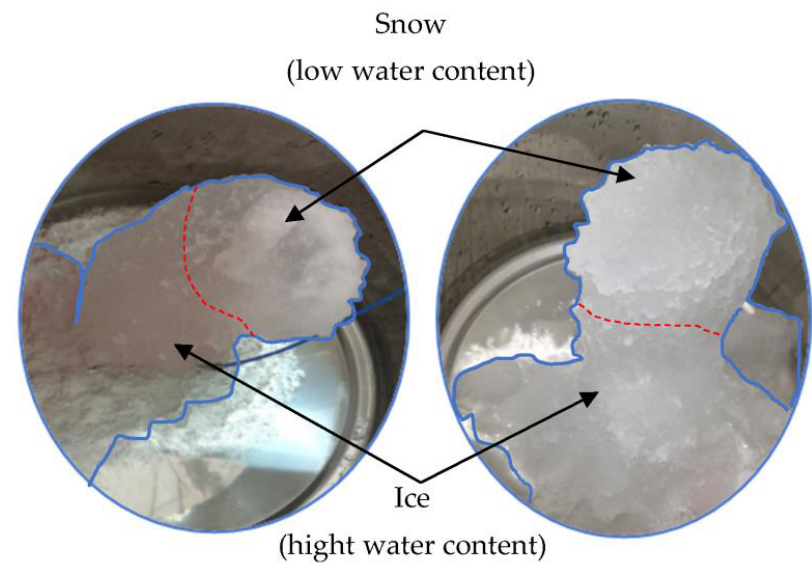
Figure 4. Columnar ice slurry generated by subcooled water.